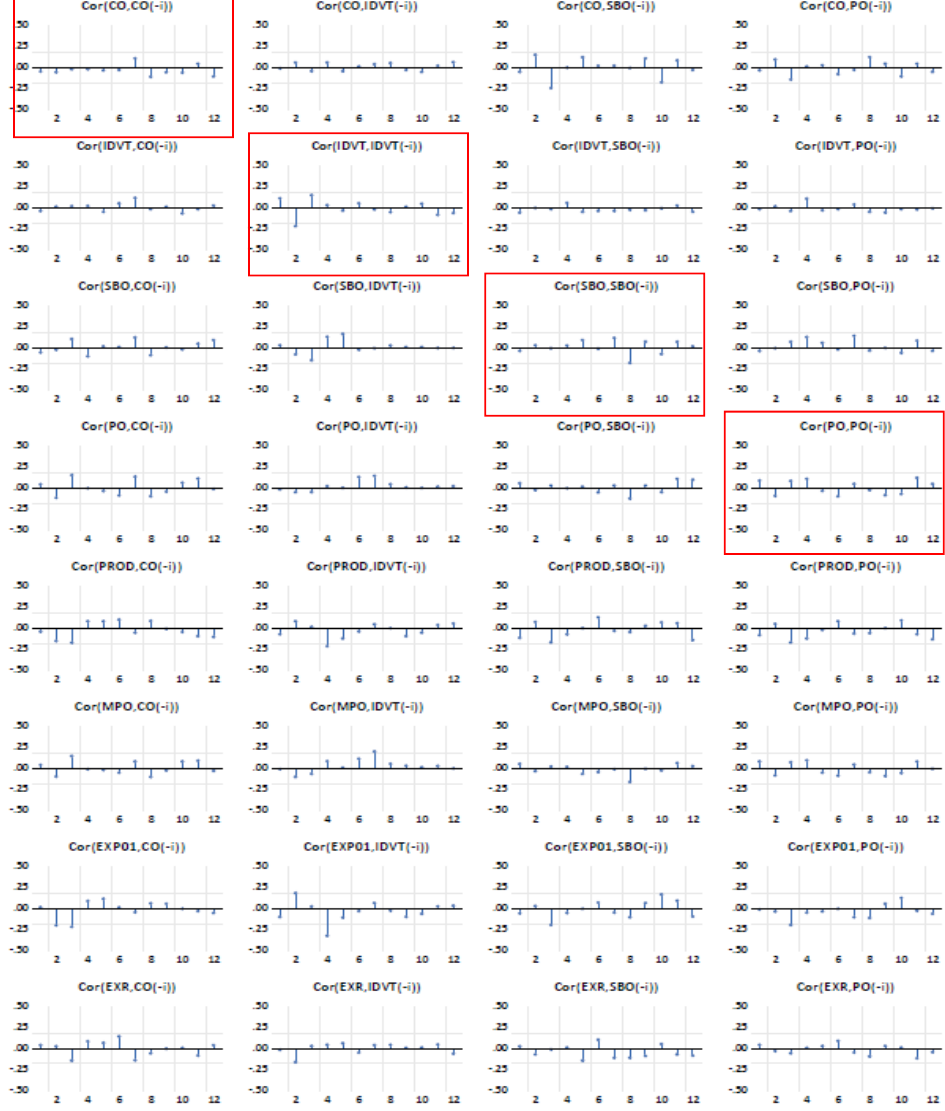
Figure A1. Plots of autocorrelation coefficients of error terms of any of the time series with its own lagged (diagonal) and also with the other time series’ lagged (o ff− diagonal).